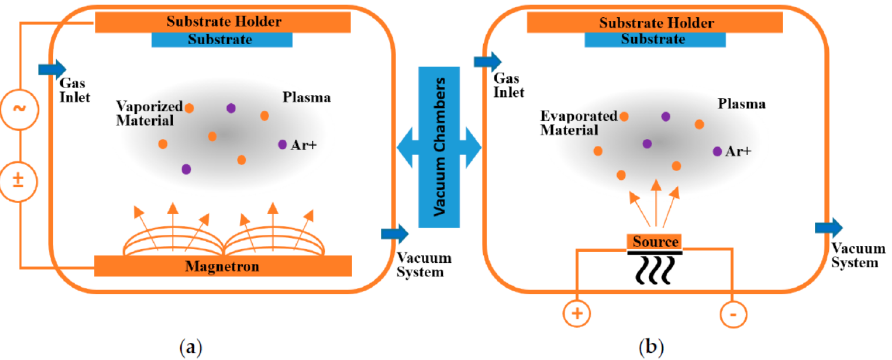
Figure 2. Schematic showing integrated physical vapor deposition (PVD) processes: ( a ) magnetron plasma sputtering, and ( b ) plasma enhanced thermal evaporation. Reproduced from [72], ©2018, the authors.